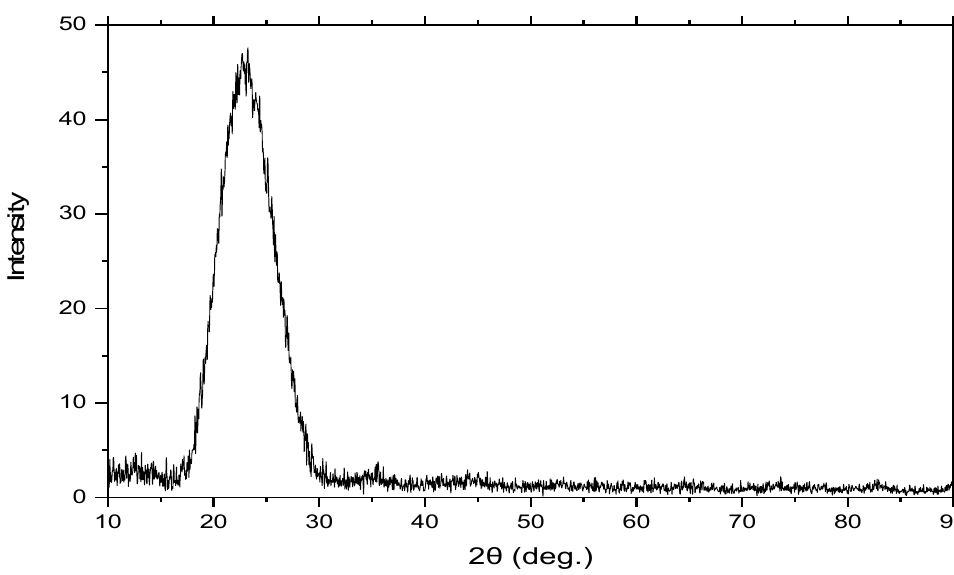
Figure 3. XRD diffractogram of synthesized SiO 2 NPs from RHA.